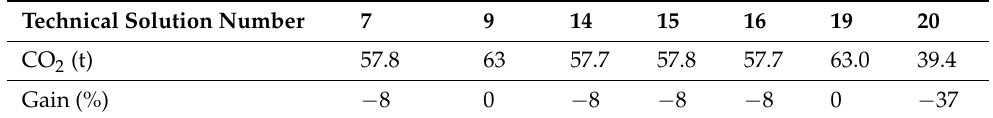
Table 4. CO 2 emissions per technical